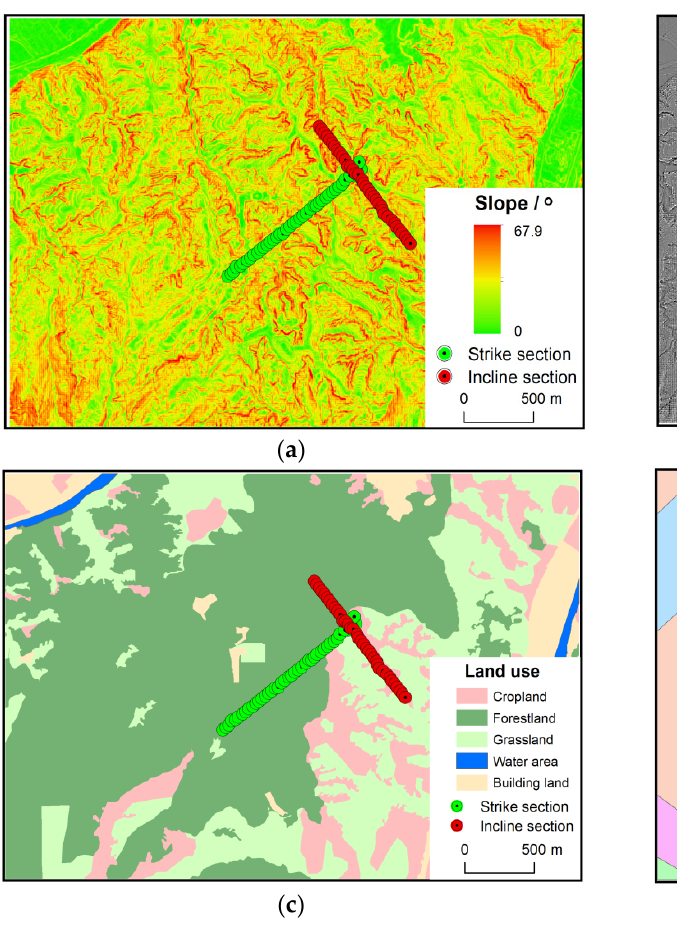
Table 1. The basic situation of the